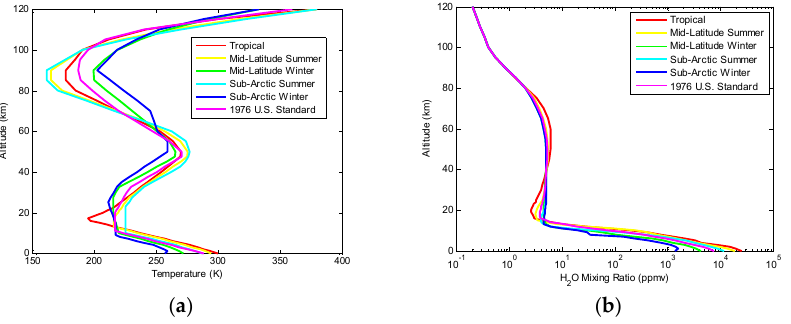
Figure 3. Humidity and temperature profiles of six representative atmosphere conditions: ( a ) temperature profiles; and ( b ) humidity profiles.